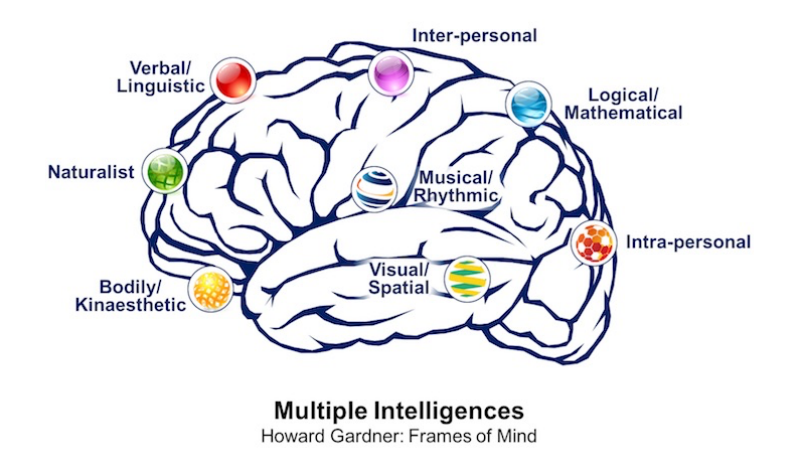
Fig. 5. Multiple Intelligences/ Howard Gardner